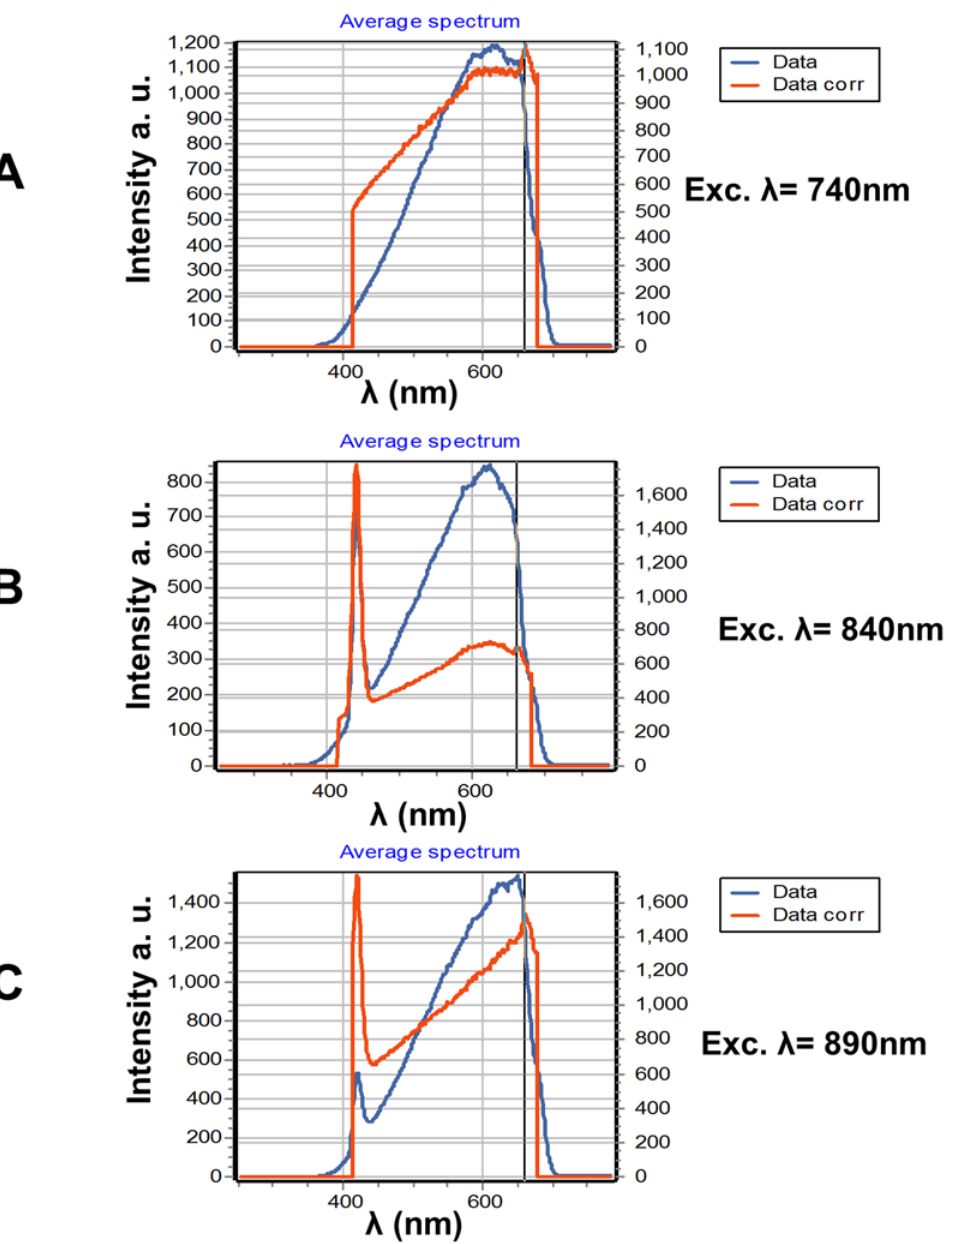
Fig 3. Emission spectrum of the same AuNP of Fig 2 with a polarization angle of 45° excitation wavelength of (A) 740 nm, (B) 840nm and (C) 890nm. In C and B the SHG signal is very strong. The broad emission spectrum maximum depends in the wavelength of excitation.